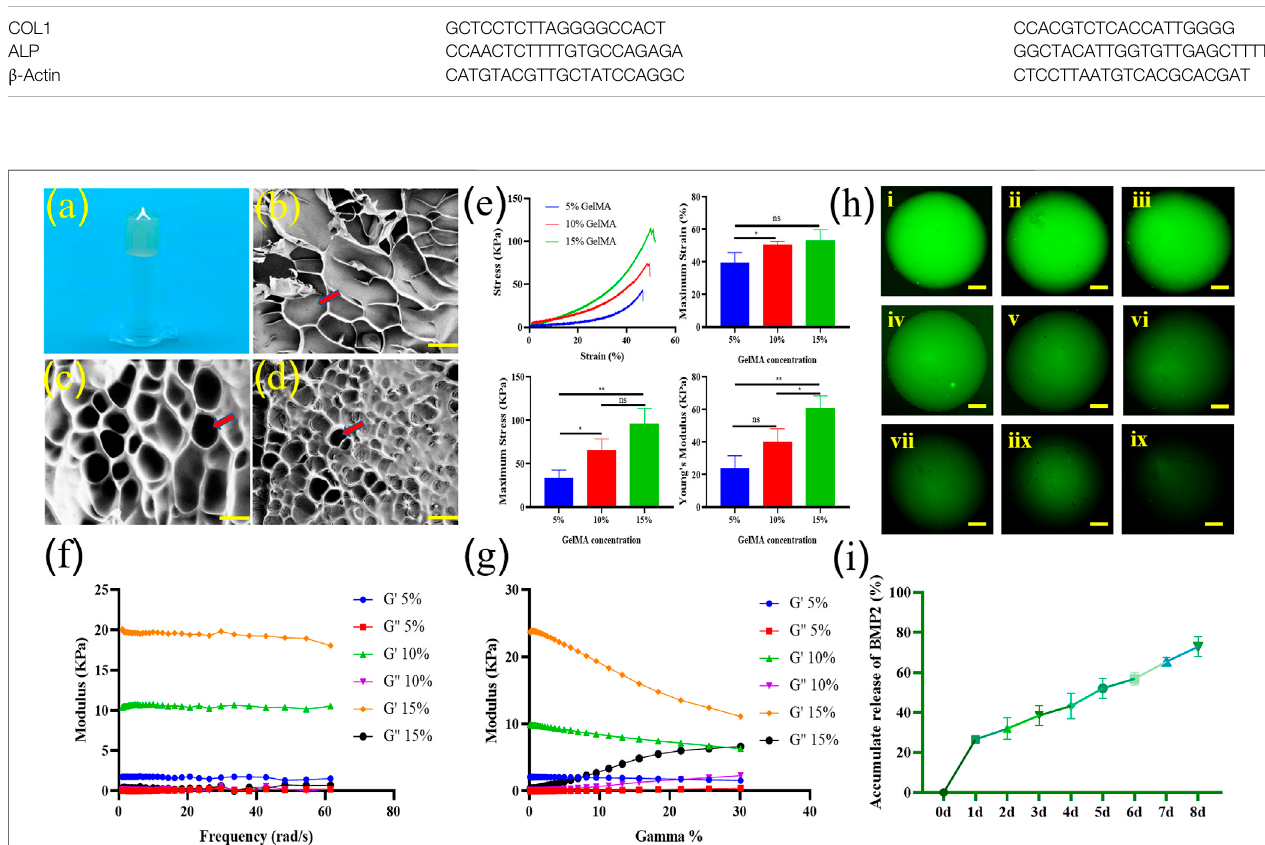
FIGURE2| PhotoofabioactiveGelMAscaffold (A) .Scanningelectronmicroscope(SEM)imageof5%GelMA (B) ,10%GelMA (C) ,and15%GelMA (D) con fi rmed the highly porous nature of the hydrogel with interconnected pores. The pore shape were marked with arrow (bar = 100 μ m). The compressive mechanical characteristics, such asstressstraincurves, maximum strain (%), maximum stress(kPa), and Young ’ smodulus values ofthe GelMA scaffolds at various concentrations were assessed ( n = 3) (E) . Dynamic viscoelastic characteristics of different concentrations of GelMA scaffolds (F) . Rheological property curves of different concentrations of GelMA scaffolds (G) . Slow release of fl uorescent macromolecular protein Rhodamine B in 0-8d hydrogel scaffold [ (H,I) , ix]. Release curve of BMP2 in scaffolds ( n = 3) (I) . ns indicates no signi fi cant differences; * indicates signi fi cant differences, p < 0.05; ** indicates highly signi fi cant differences, p <